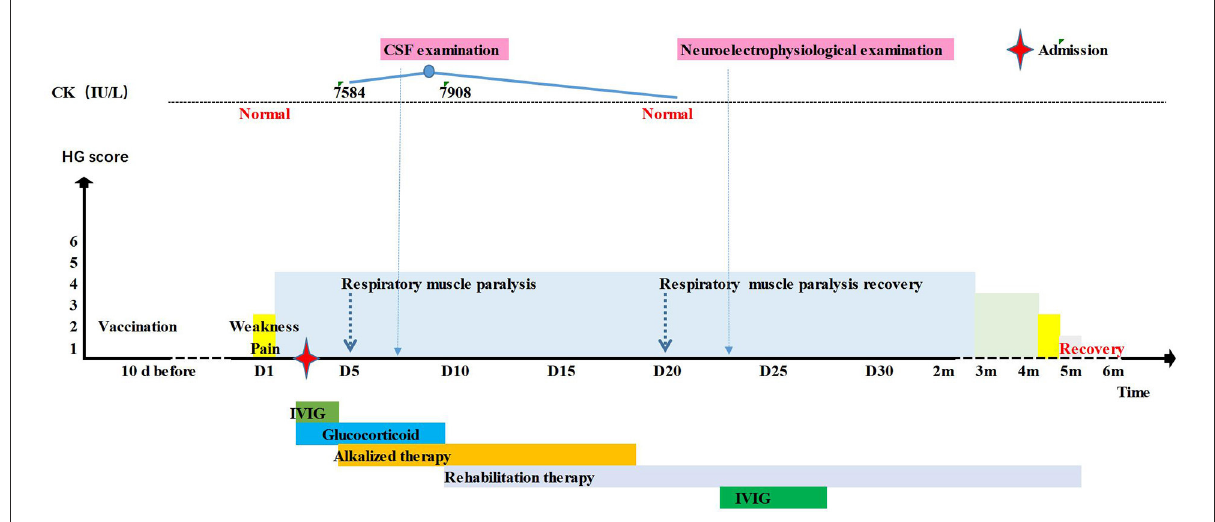
FIGURE1 Timeline of the patient 1’s clinical manifestations, laboratory examinations and treatments.